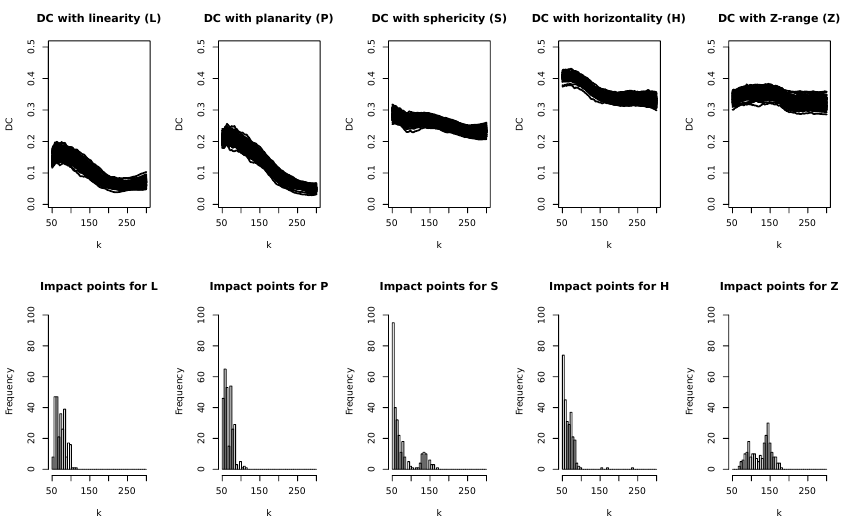
Figure 10. Distance correlation functions for each of the features ( top )) and histogram of critical points. There are 100 curves, hence the same number of impact points, that were obtained by random sampling the data.